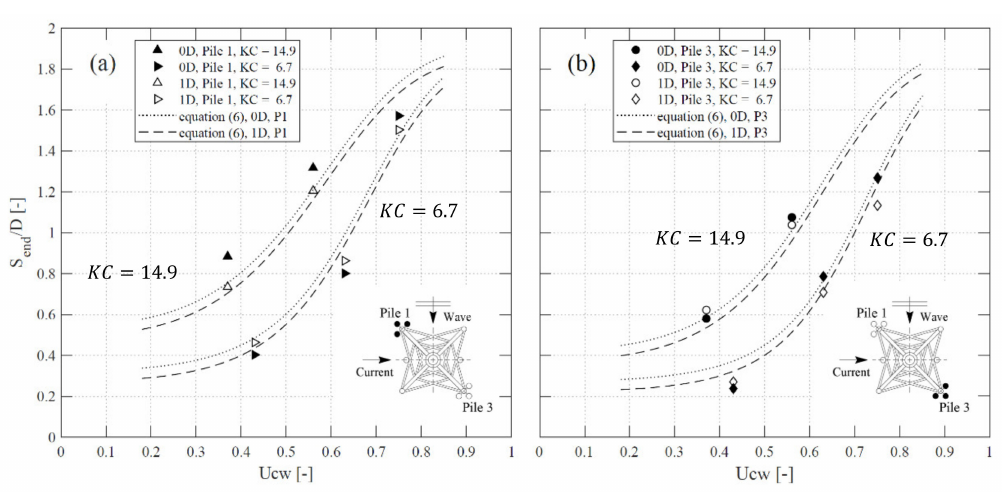
Figure 4. Measured dimensionless scour depth S end / D plotted over U cw for Tests 1–5 0D and Tests 1–5 1D for the upstream side of the structure (( a ), Pile 1), as well as for the downstream side (( b ), Pile 3), in comparison to Equation